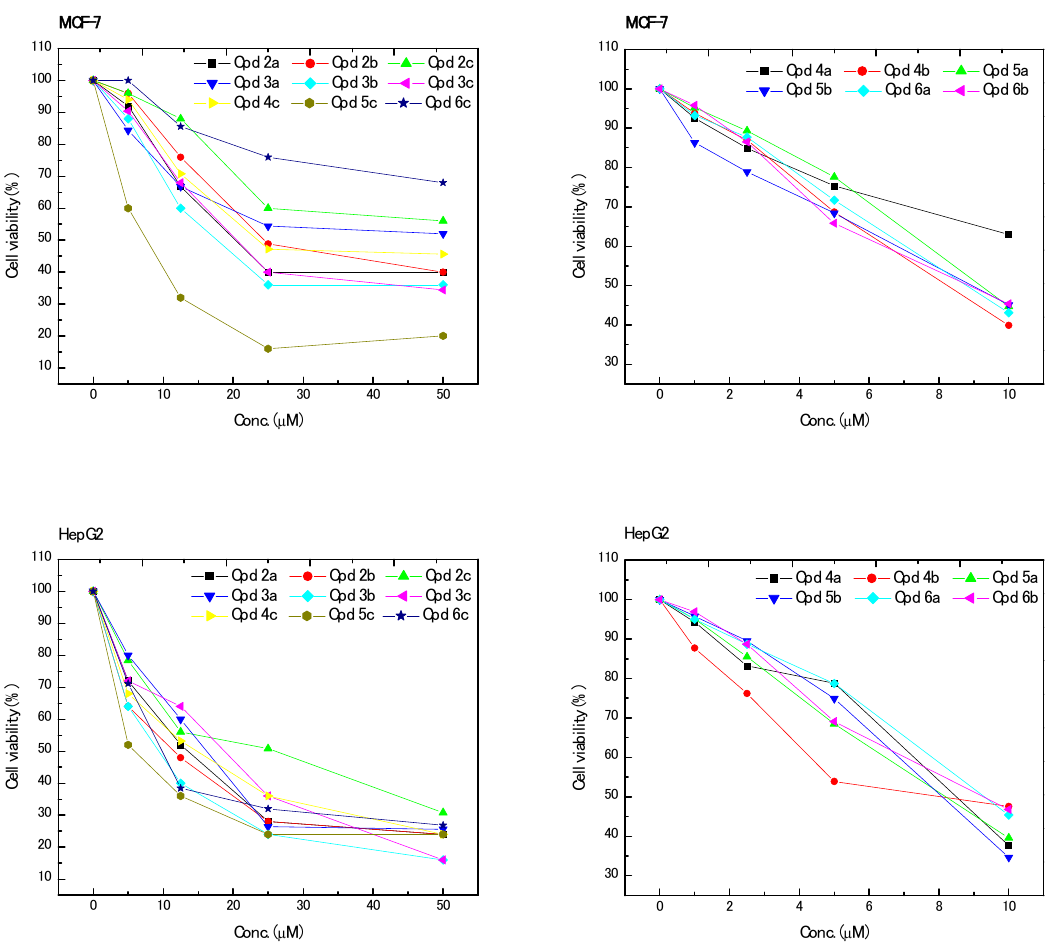
Figure 3. Effect of different concentrations of the prepared compounds on the viability of HepG-2 and MCF-7 cell lines. Data are expressed as means ± SEM (standard error mean).